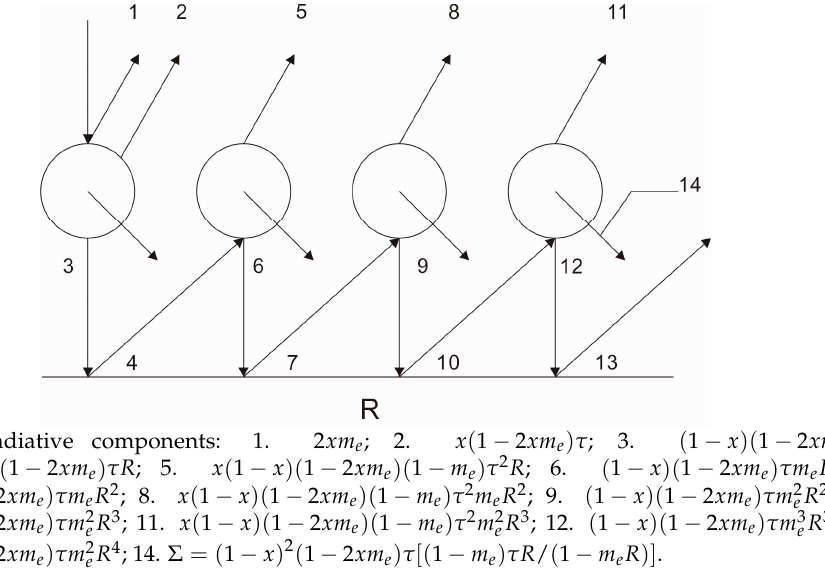
Figure 1. A schematic representation of Melamed theory [3,4]. x is the particle backscattering ratio, m e is the external reflectance, τ is the transmittance of a particle, R is the reflectance of underlying material. Their equations can be found in Nomenclature. The fonts in reddish tone denote the sublayer backscattering ratio used by corresponding components.